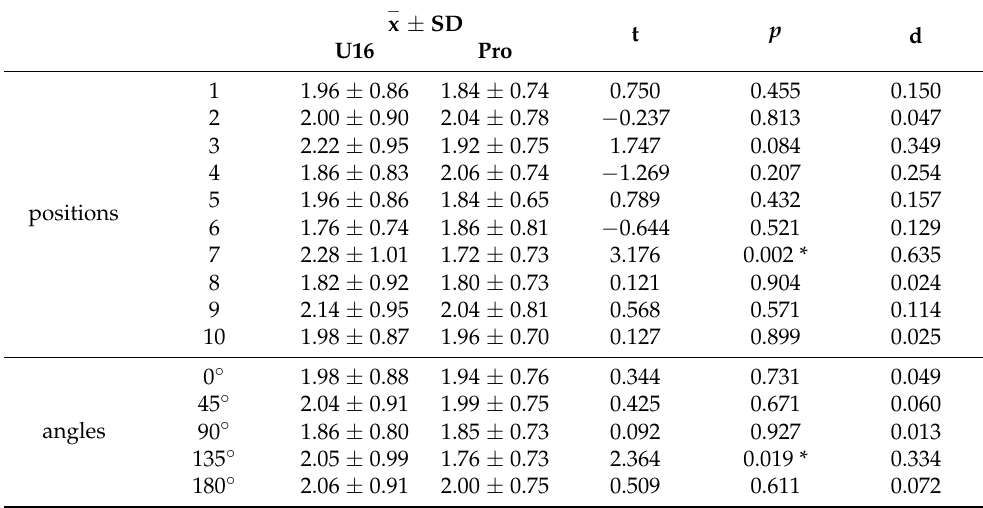
Table 4. Between-group comparison for number of fixations, according to position and angle.